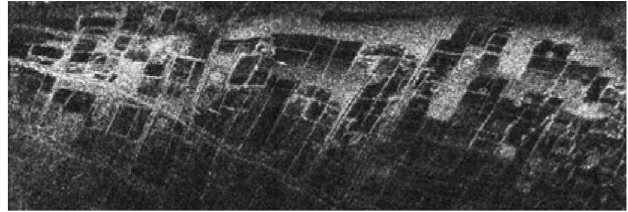
Figure 14. Real data processing results by the proposed